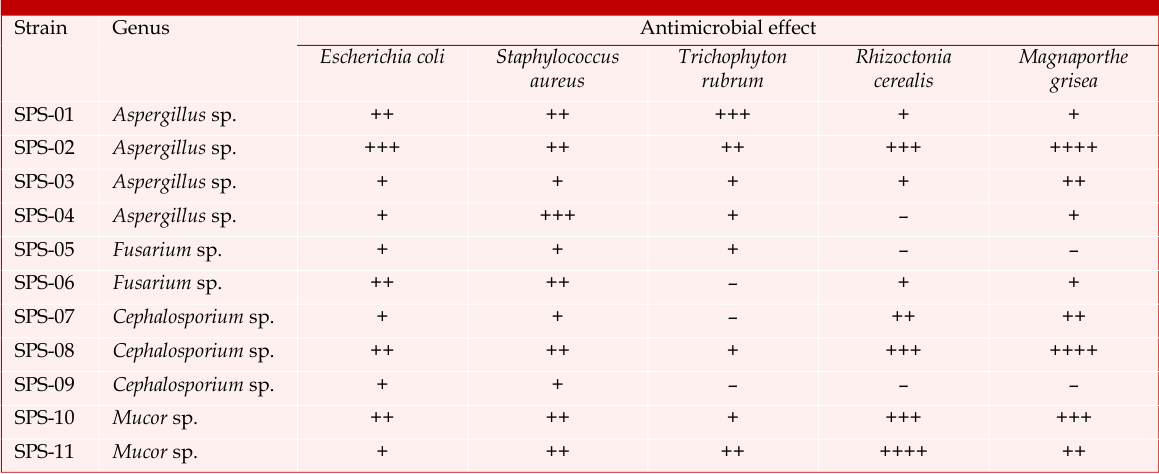
Anti-microbial effects of extracts of 11 endophytic fungi from Artemisia annua